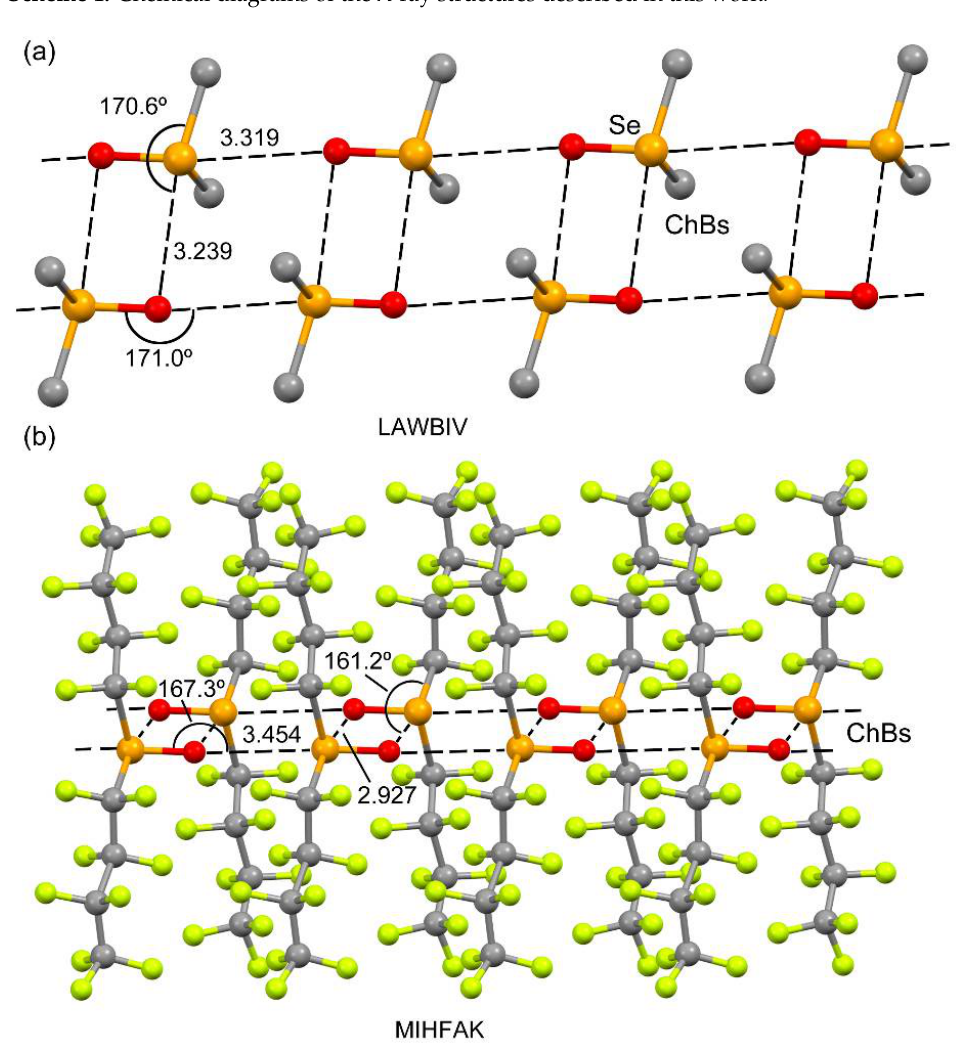
Figure 2. X-ray structures of LAWBIV ( a ) and MIHFAK ( b ). H atoms omitted and distances in Å.